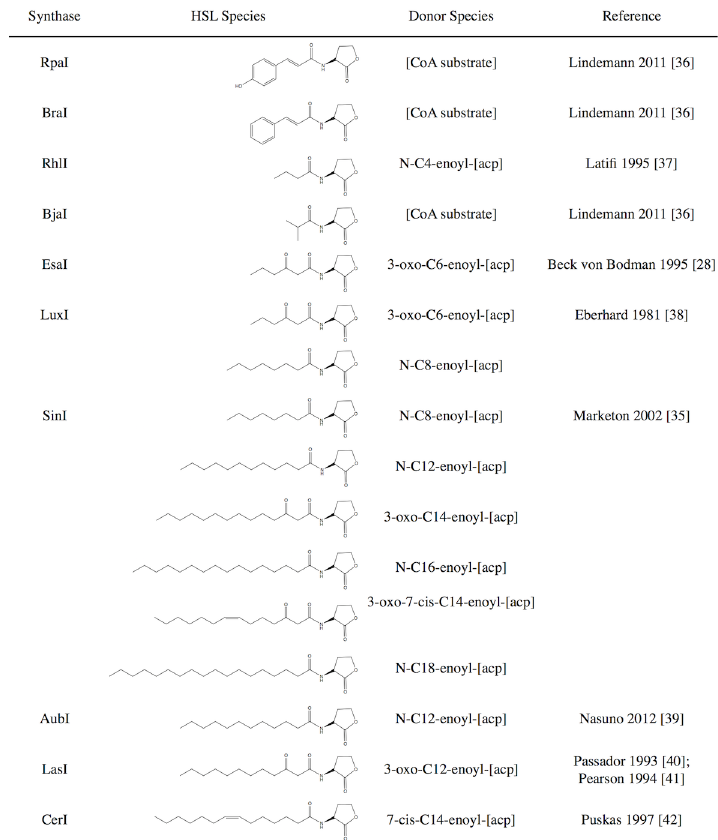
Fig 2. Synthases used in this study. The table lists the synthase symbol, the structures of the homoserine lactone (HSL) species produced by the native organism, and the acyl-carrier protein (ACP) or coenzyme A (CoA) donor species catalyzed by the synthase.